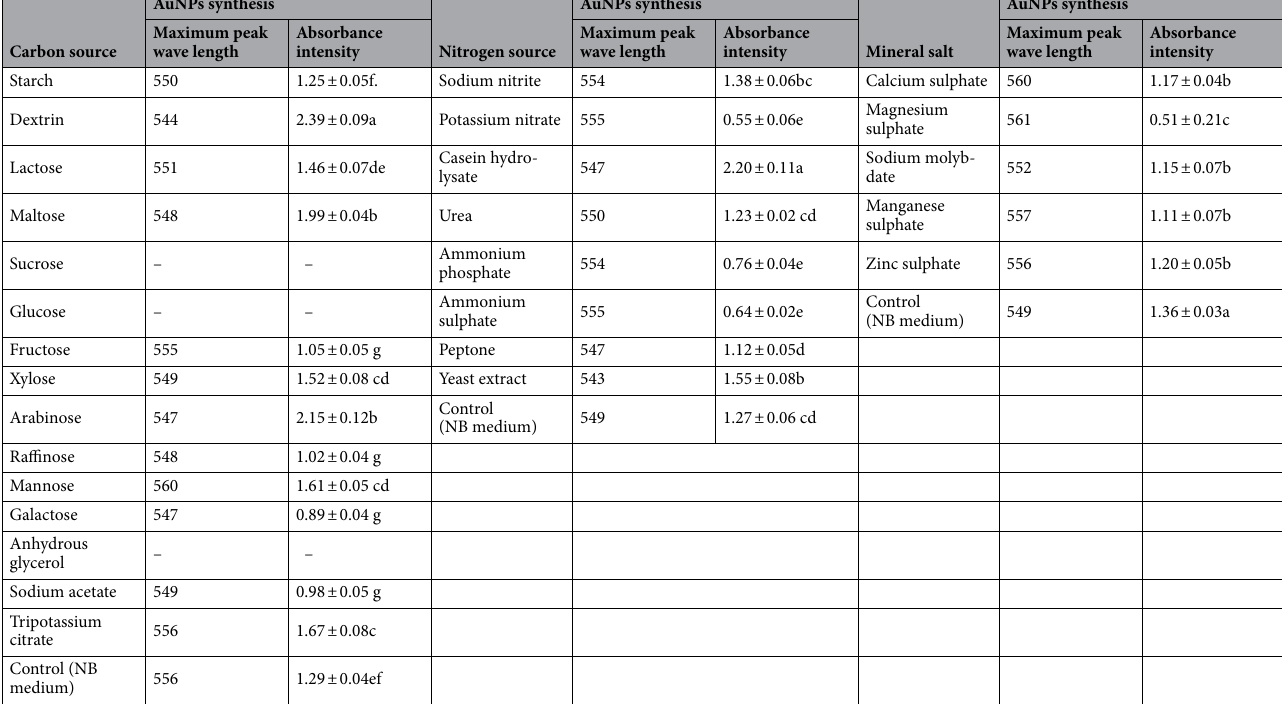
Table 5. Effect of different (a) carbon sources (1%), (b) nitrogen sources and (c) metal ions on the synthesis of AuNPs using the extracellular filtrate of Bacillus subtilis NRC1. Absorbance is presented as means ±